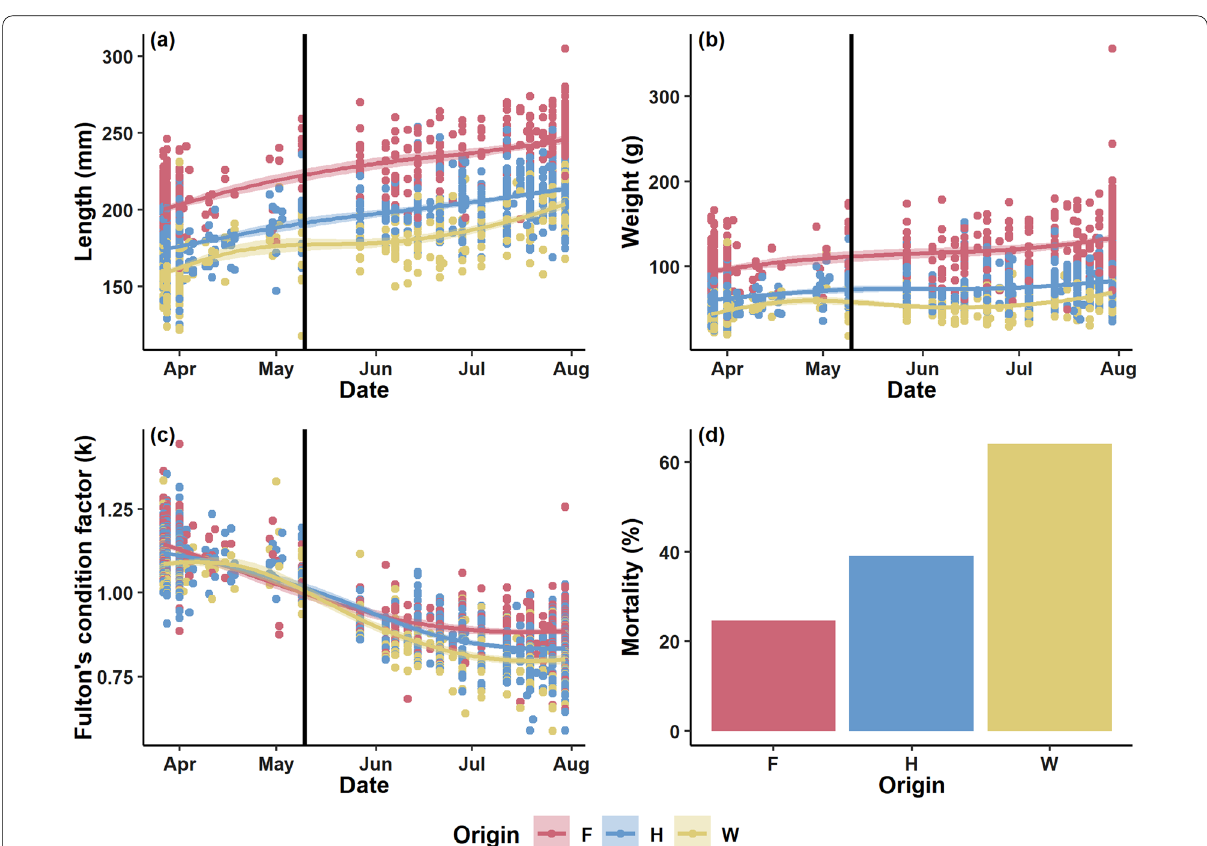
Fig. 2 Loess regression of growth trajectories (length ( a ), weight ( b ) and Fulton’s condition factor ( c )) of fish from different genetic backgrounds throughout the experiment. The black line indicates the point in time of the transfer from the freshwater stage to the sea pens. Mortality ( d ) was calculated as the difference in fish counts between the start and end of the experiment. Origin: F